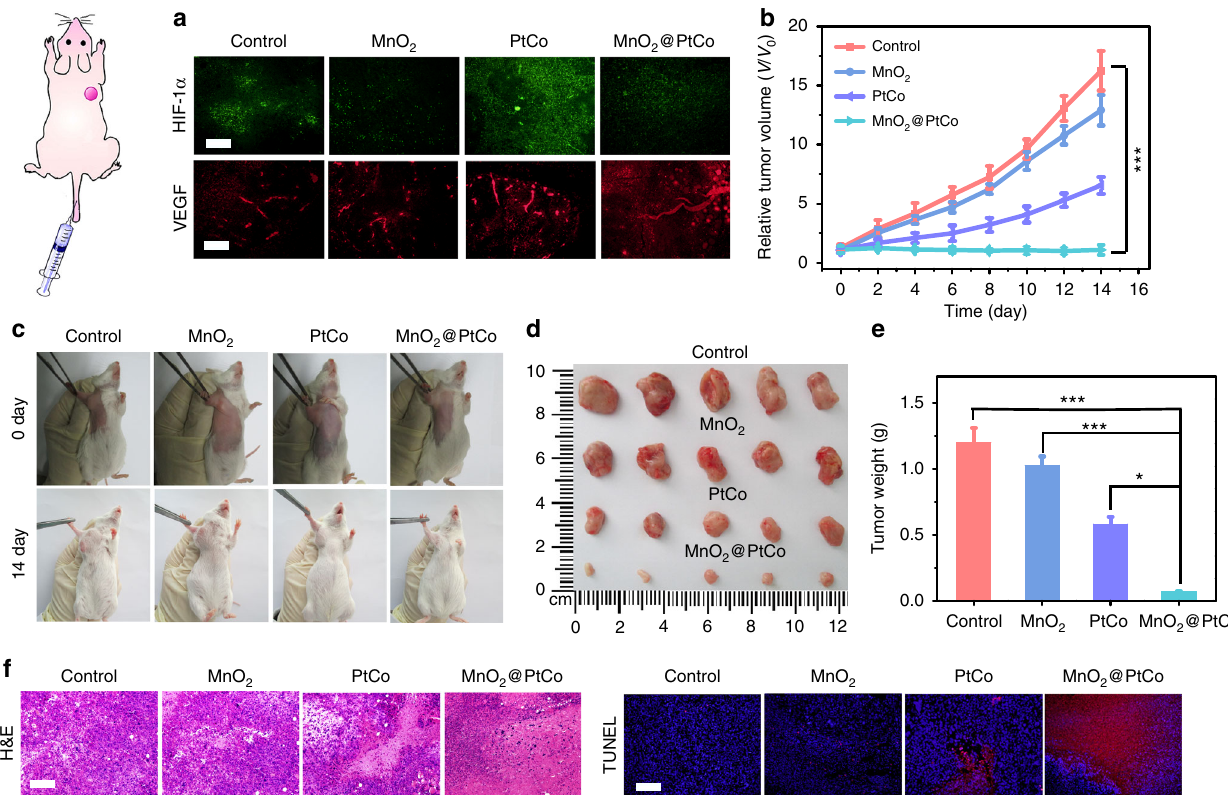
Fig. 9 In vivo therapeutic performance of MnO 2 @PtCo nano fl owers by intravenous injection. a After 24 h of various nanomaterials treatments, representative immuno fl uorescence images of tumor slices with HIF-1 α and VEGF staining. Scale bars are 100 μ m. b Changes in tumor volumes used to evaluate the effectiveness of various treatments (i.v.) on treating tumor-bearing mice. c Photographs of the 4T1 tumor-bearing mice before treatment and after 14 days post injection. d Photos of the dissected tumors after 14 days of treatment. e The weight of the dissected tumors after 14 days of treatment. f H&E and TUNEL staining of tumor tissues at the 14th day. Scale bars are 100 μ m. Asterisks indicate signi fi cant differences ( * P < 0.01, ** P < 0.005, *** P < 0.001), analyzed by unpaired Student ’ s two-sided t test. Data were presented as mean ± s.d. ( n =